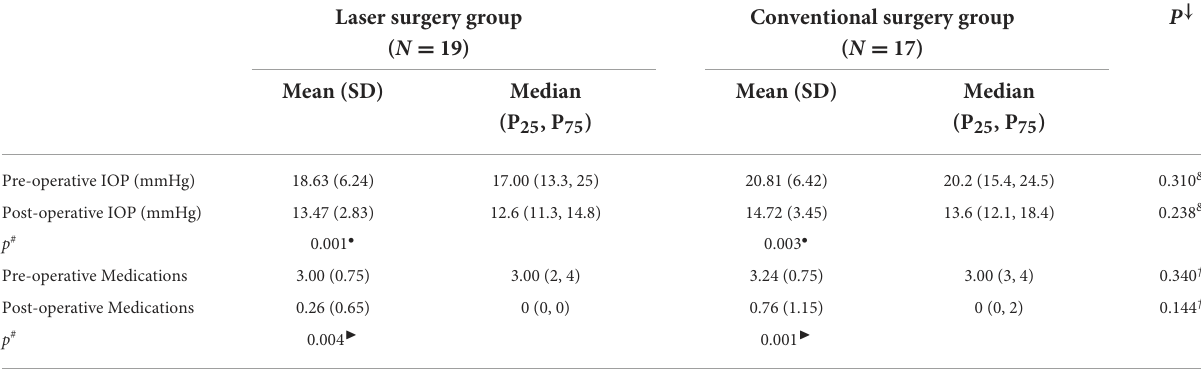
TABLE 5 Pre-operative values and values post-operative 1 week for both groups. Excluding the cases wherein compound trabeculectomy or trabeculotomy was performed as the alternative approach. Laser surgery